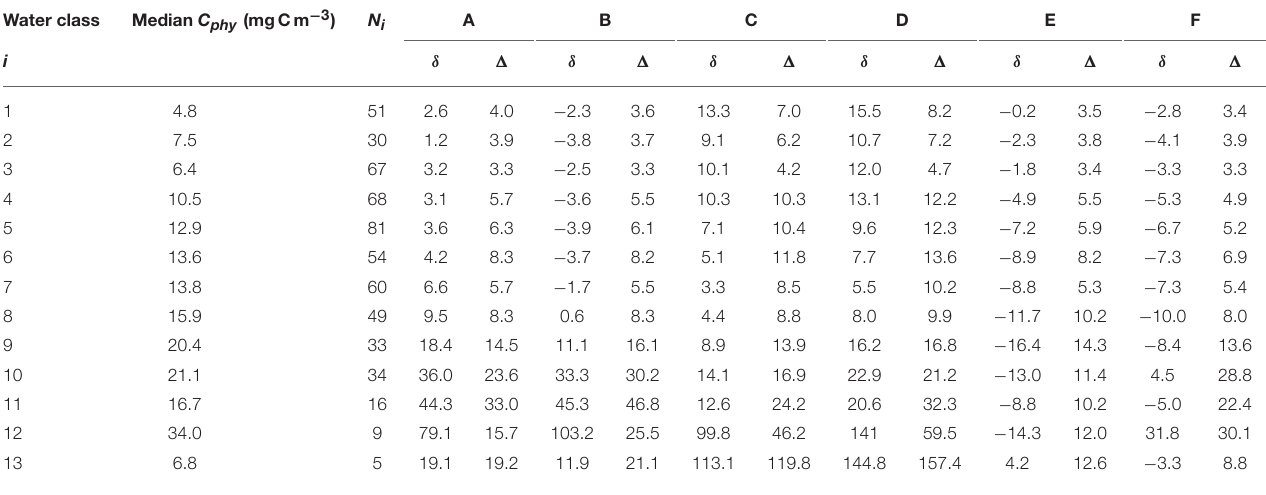
TABLE 5 | Median C phy from in situ matchups and non-log average bias ( δ ) and un-biased RMSD ( 1 ) of the different algorithms (algorithms A–F, columns headers)